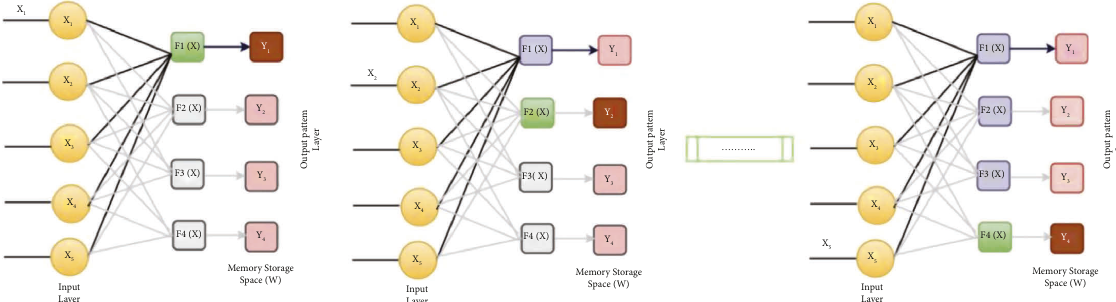
Figure 3: Memory-associated neural network structure.